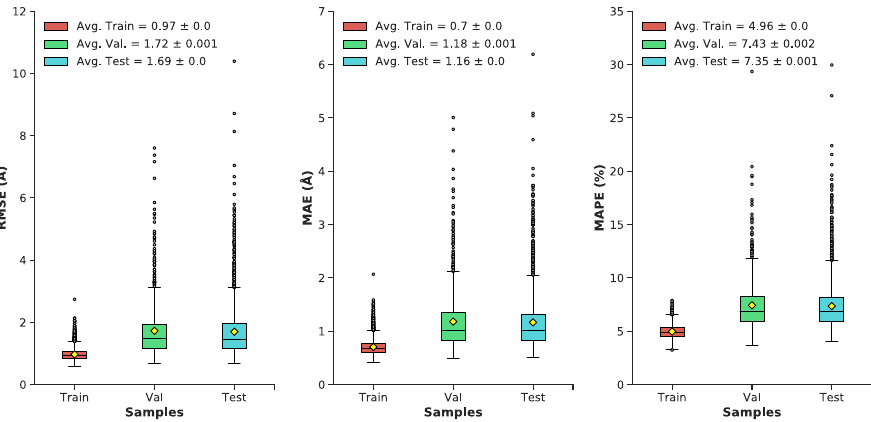
Figure 5. Boxplots of distributions for the following metrics (RMSE, MAE, MAPE) for the train, validation, and test datasets: minimum, maximum, median, outliers (grey dots), average (yellow diamond) ± standard error, lower and upper